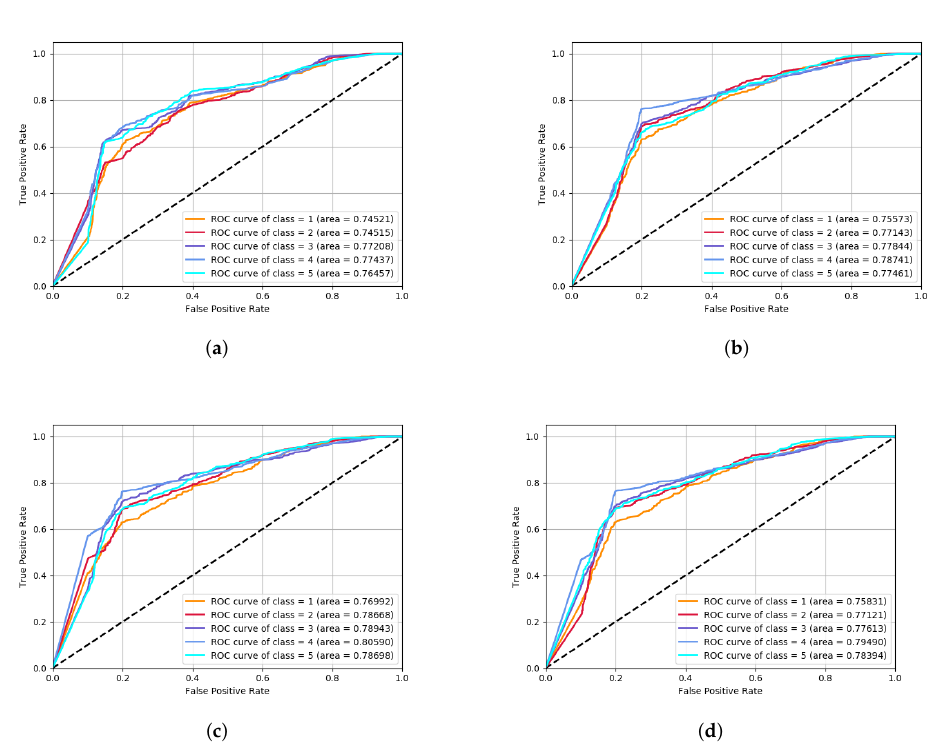
Figure 7. Training results of the CVAEWD and HMM classifier. ( a ) ROC curve of the simple average. ( b ) ROC curve of the weighted average. ( c ) ROC curve of SVM. ( d ) ROC curve of DNN.